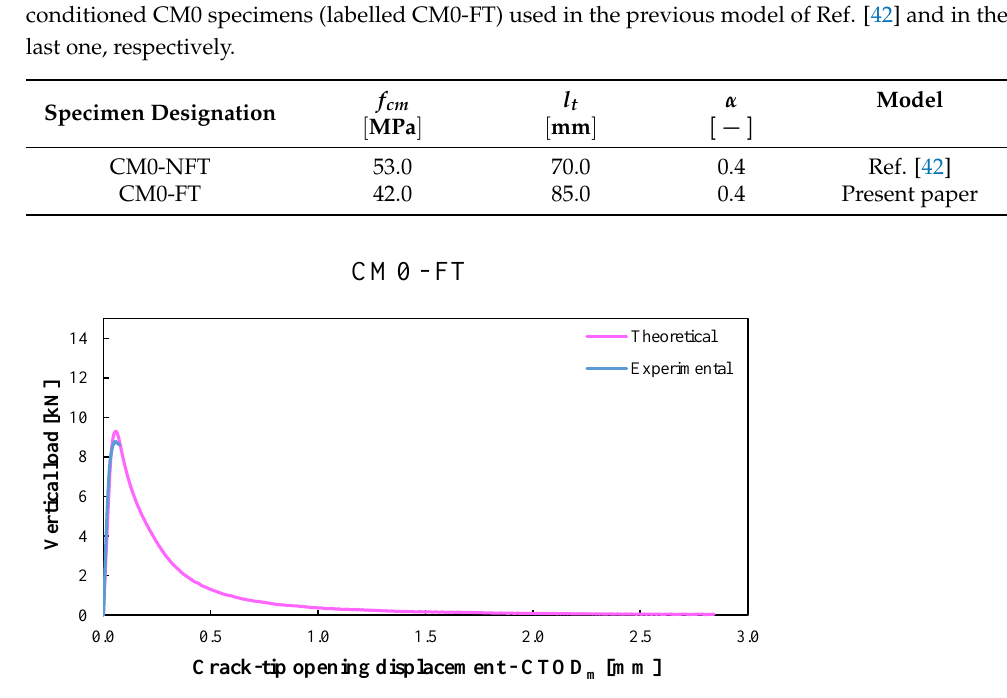
Figure 7. The average experimental 𝑃 − 𝐶𝑇𝑂𝐷 ,𝑎𝑣𝑔 curve (light-blue line) versus the average numerical 𝑃 − 𝐶𝑇𝑂𝐷 ,𝑎𝑣𝑔 curve (pink line) for conditioned CM0 specimens (labelled CM0-FT) obtained with the present model.